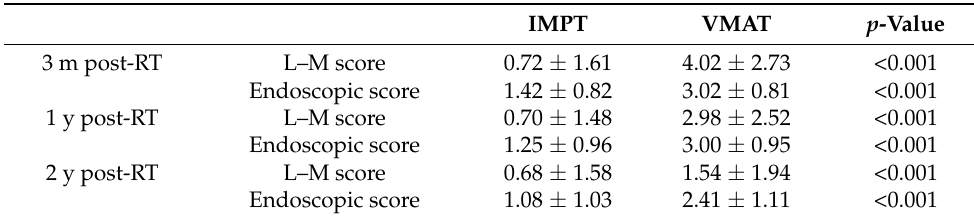
Table 2. Comparison of severity of post-irradiation sinus mucosa abnormality and localized nasopha- ryngeal inflammation in nasopharyngeal carcinoma patients treated with intensity-modulated proton therapy and volume-modulated arc therapy.